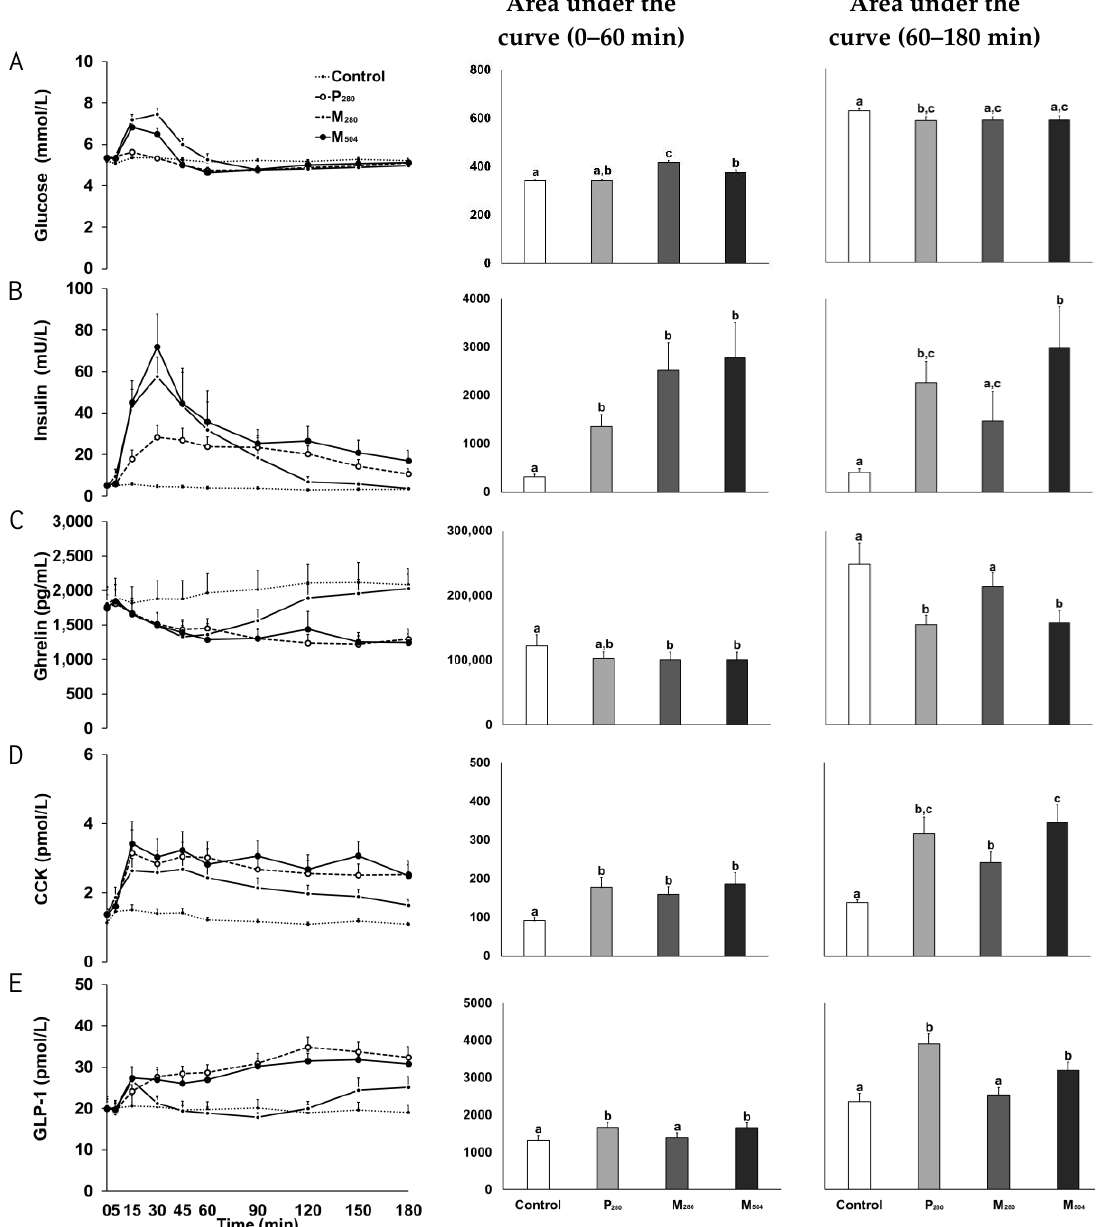
Figure 2. Blood glucose (A; mmol/L), plasma insulin (B; mU/L), ghrelin (C; pg/mL), cholecystokinin